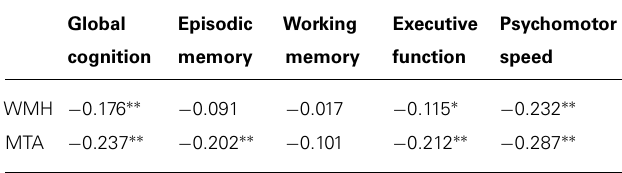
Spearman rank correlations were calculated. A higher cognitive domain score representsbetterperformance. MTA:medialtemporallobeatrophy;WMH:white matter hyperintensities. ∗ p < 0.05, ∗∗ p <